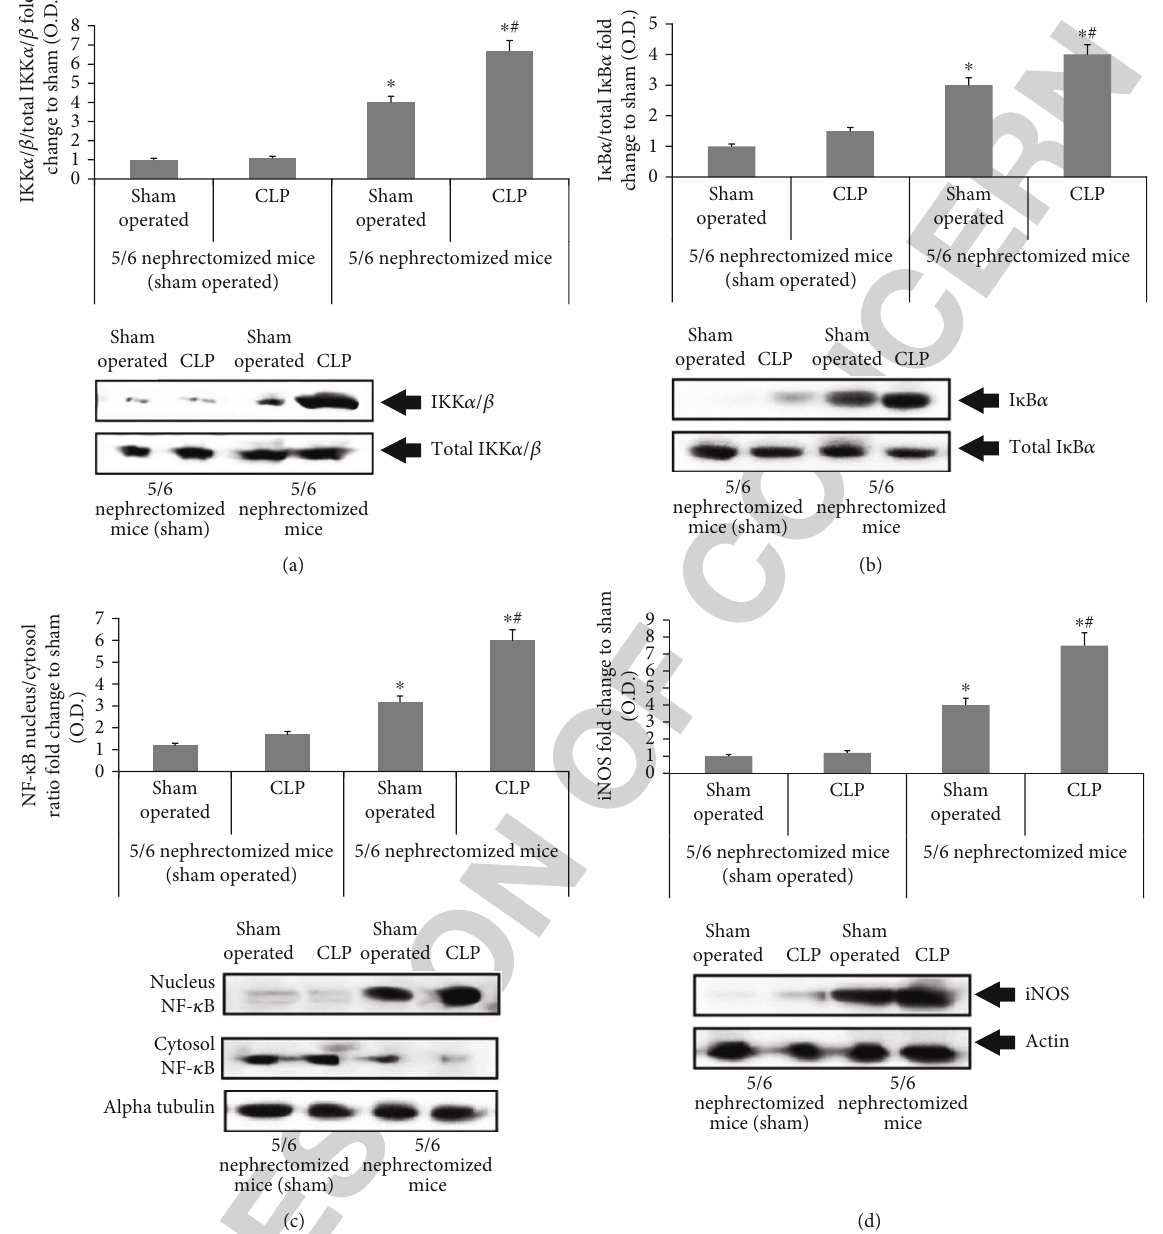
Figure 4: CLP enhances the phosphorylation levels of IKK α / β and IkB α , the nucleus translocation of NF- κ B, and expression of iNOS. 5/6 nephrectomized sham or 5/6 nephrectomized mice were submitted to CLP or sham surgery. The signaling e ff ects on cardiac tissue were evaluated after 24 hours. The optical density was assessed. (a) Optical density of phosphorylated IKK α / β against total IKK α / β levels normalized against corresponding sham band. (b) Optical density of phosphorylated IkB α against total IkB α levels normalized against corresponding sham band. (c) Levels of NF- κ B in nuclear and cytosolic fractions presented as nucleus/cytosol ratio; the results were normalized against corresponding sham band. (d) Levels of iNOS normalized against actin as loading control. All the analysis was performed in triplicate. ∗ P < 0 : 05 compared to 5/6 nephrectomized sham mice with described treatment; # P < 0 : 05 compared to the corresponding sham-operated